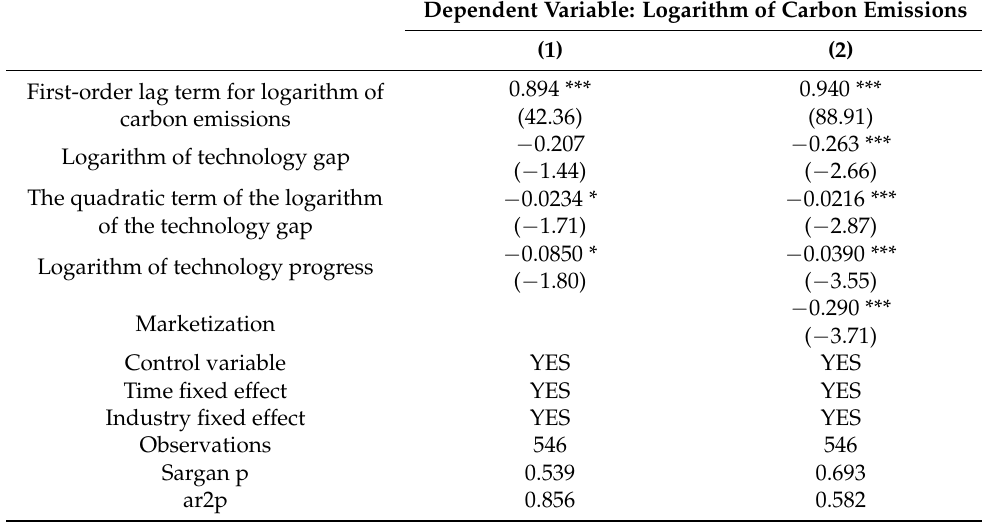
Table 3. Estimation results including market